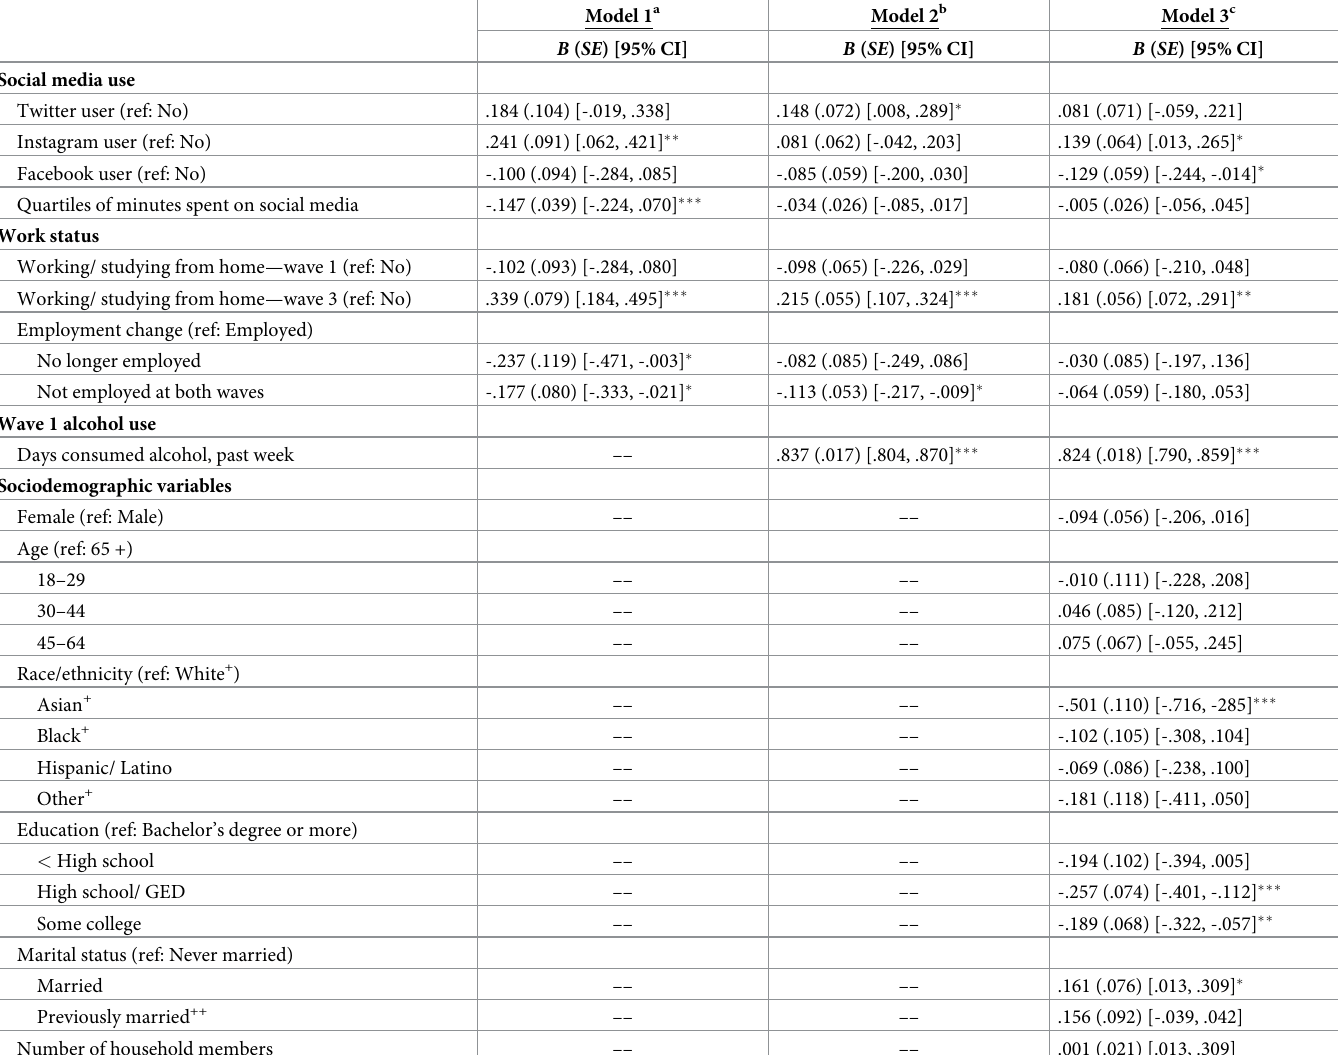
Table 3. Hierarchical linear regression models for wave 3 alcohol use